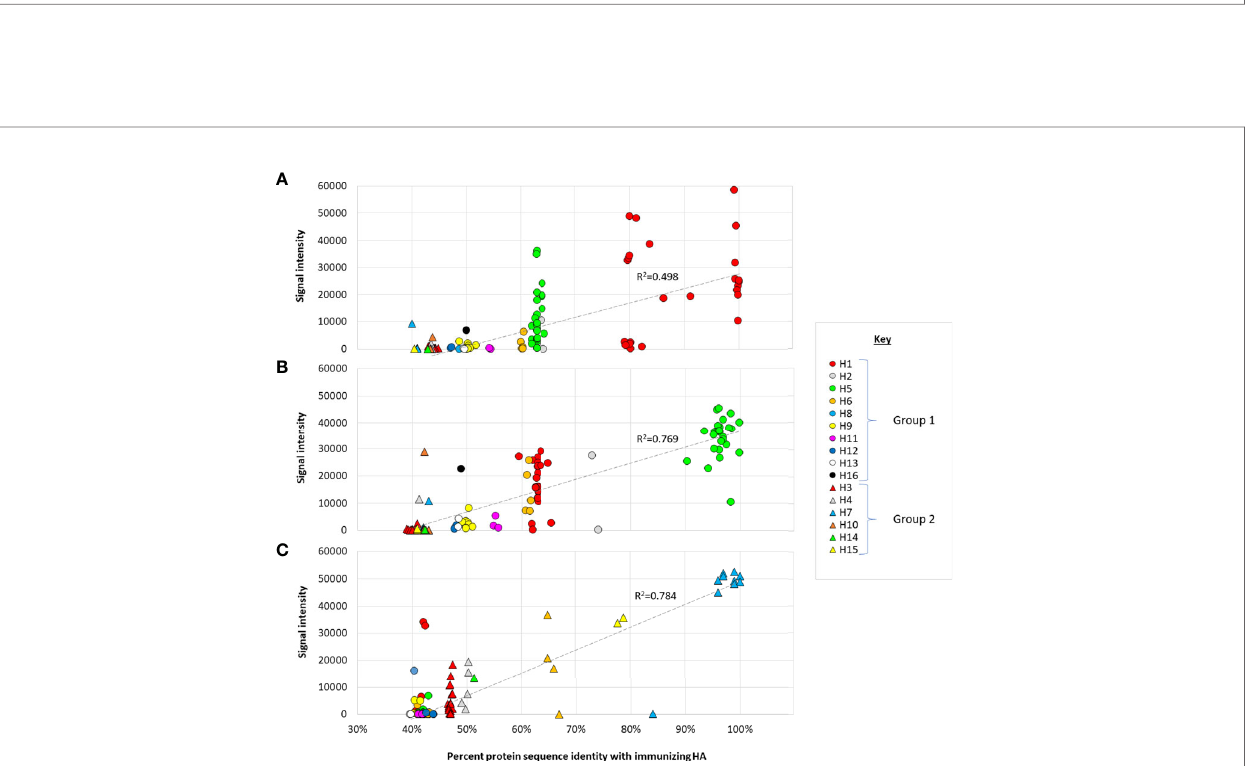
FIGURE 3 | Prime-boost administration of individual HAs. For comparison with single-dose administration, C57Bl/6 mice were administered individual HAs in IVAX-1 as described in Figure 2 and boosted on d14 and d42. Plasma samples were collected on d10, d28 (post-boost 1, PB1) and d56 (PB2). Panels (A – C) as per Figure 2 .